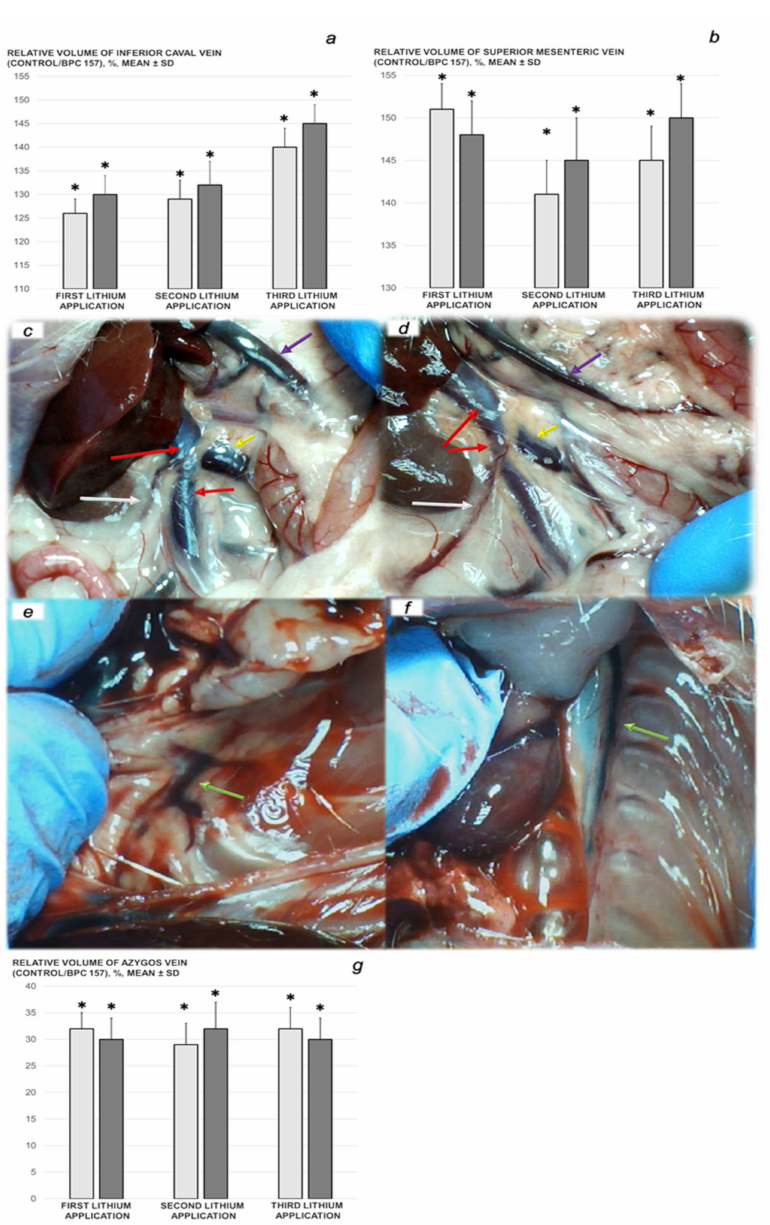
Figure 3. Blood vessels presentation ( a – g ). Relative volume of the veins (inferior caval vein ( a ), superior mesenteric vein ( b ), azygos vein ( g ), volume control/volume BPC 157, %, in the rats that received the first, second, and third lithium administration (500 mg/kg/day intraperitoneally for 3 consecutive days). BPC 157 10 µ g/kg (light gray bars), 10 ng/kg (dark gray bars); saline 5 mL/kg (not shown) given intraperitoneally after each of the three lithium sulphate administrations. Six rats/group/interval. Means ± SD, * p < 0.05, at least, vs. control ( c – f ). Collateral pathways (azygos vein (green arrow)) and veins congestion gross presentation in lithium-treated rats that received BPC 157 therapy (right) or saline medication (left). Inferior caval vein (red arrow) and its tributary (left) renal vein (yellow arrow), and right testicular vein (white arrow), and superior mesenteric vein (violet arrow) presentation, congested in controls ( c ) and non-congested and functioning in BPC 157-treated rats ( d ). Azygos vein presentation ( e , f ), almost disappeared and congested in controls ( e ), and functioning in BPC 157-treated rats ( f